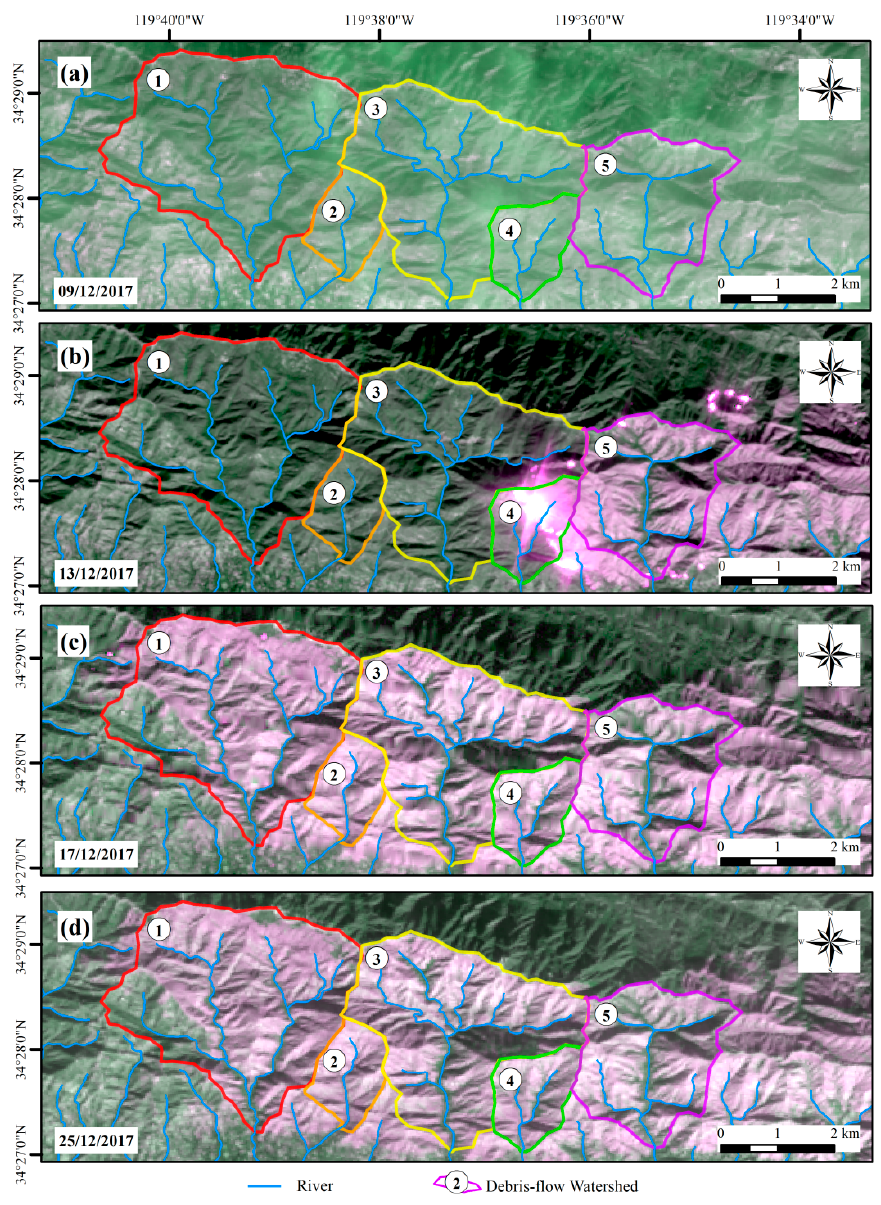
Figure Figure 5. Fire process around Montecito area analyzed by remote sensing images of: ( a ) 9 December 2017; ( b ) 13 December 2017; ( c ) 17 December 2017; ( d ) 25 December 2017.